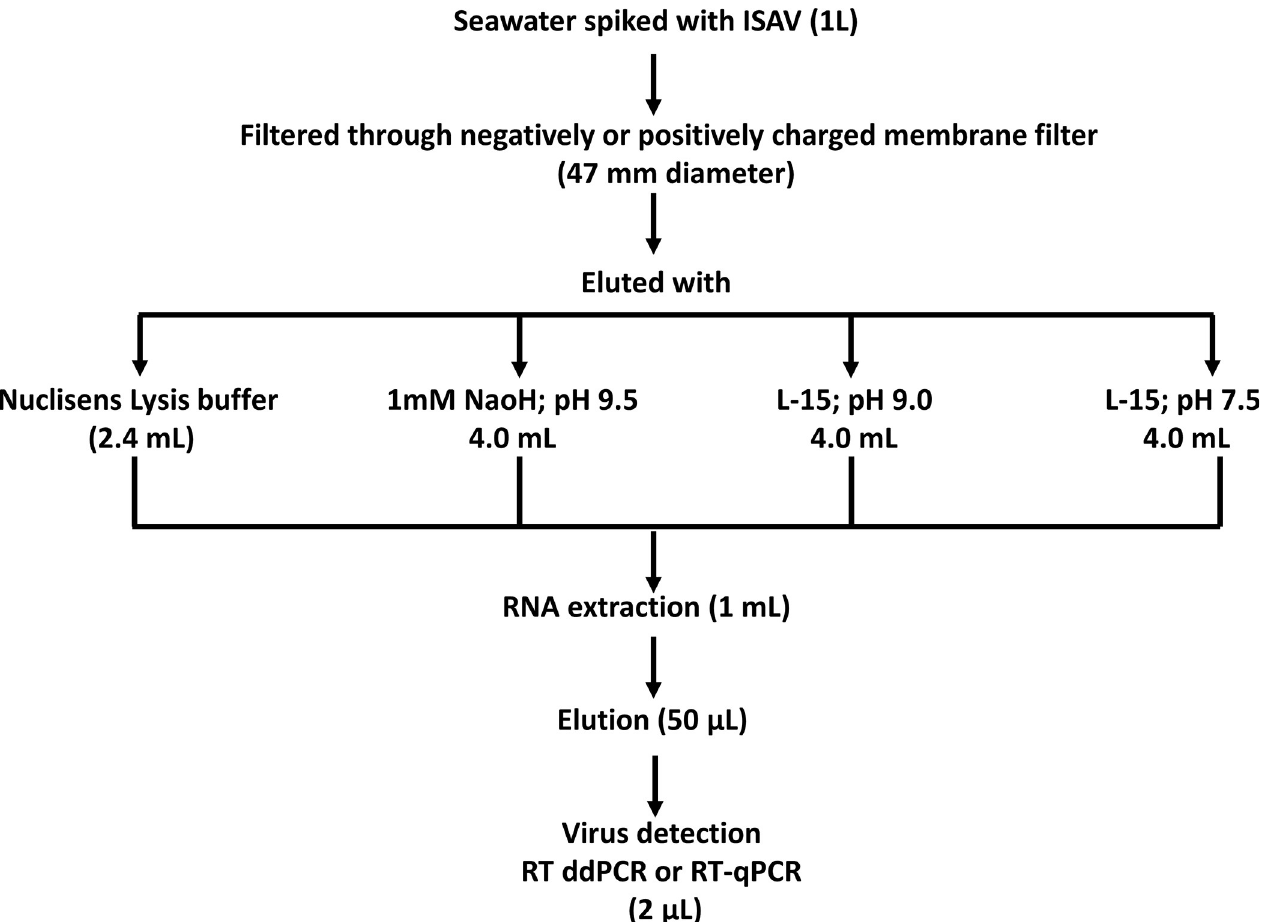
Fig 1. Schematic illustration of different approaches of ISAV concentration from seawater samples and virus detection, using RT-qPCR and RT-ddPCR methods.